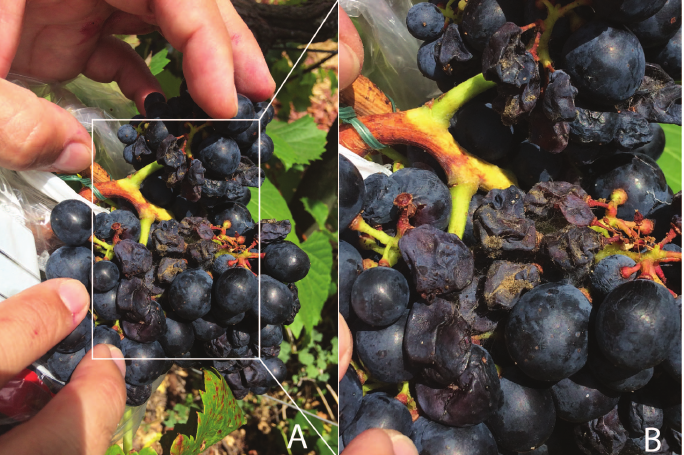
Figure 1. ( A ) Cluster of Vitis vinifera cv. Trincadeira infected with Botrytis cinerea at the harvest stage (EL38). Symptomatic infected grapes in the centre of the cluster show signs of dehydration, and sporulation of B. cinerea was visible, which is highlighted in ( B